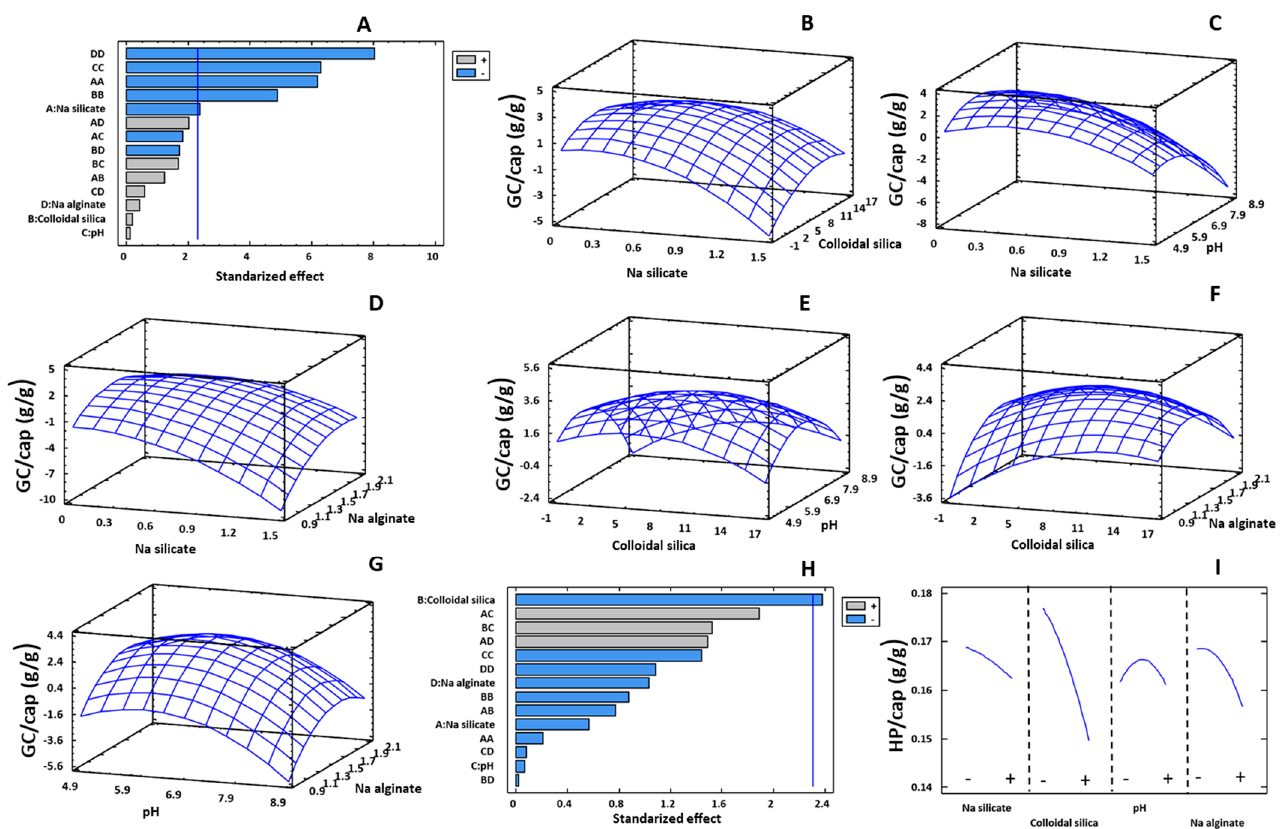
Figure 1. Pareto chart of standardized e ff ect for GC/cap ( A ). Response surface plots ( B – G ) for GC/cap as a function of the di ff erent variable factors keeping the rest of the variables at their mean level. Pareto chart of standardized e ff ect for HP/cap ( H ). Main e ff ects plot ( I ) for HP/cap ( − : low; +: high).